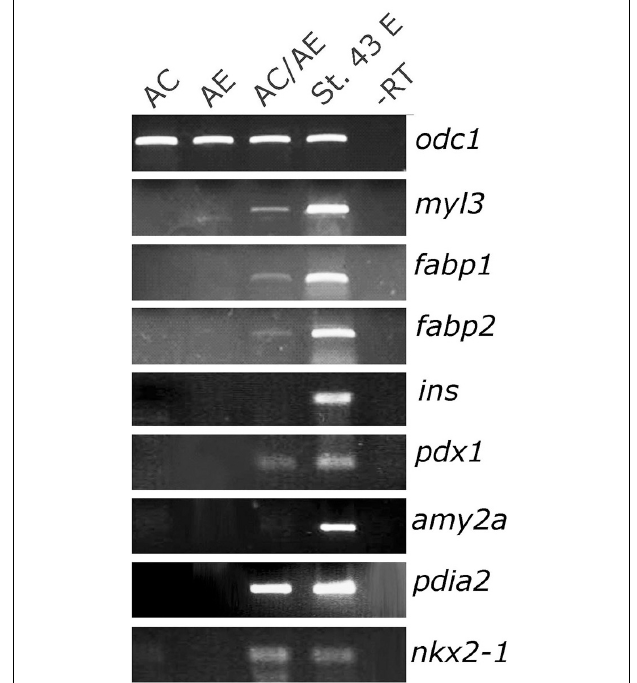
FIGURE 2 | Endoderm diversification in AC/AE conjugates. Examination of gene expression in st. 43 AC/AE explants by RT-PCR reveals expression of liver ( fabp1 ), intestine ( fabp2 ), pancreas ( pdia2 and pdx1 , but not ins and amy2a ), thyroid/lung ( nkx2-1 ) as well as ventricular cardiomyocyte ( myl3 ) markers. St. 43 E-sibling control embryo at st.